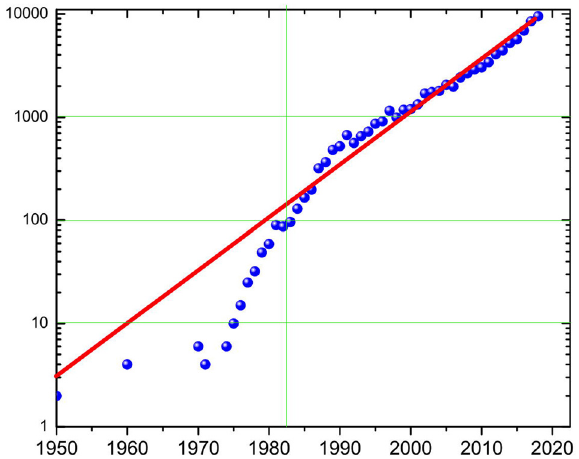
Figure 2: Yearly number of citations obtained using the Web of Science and the acronym « BN